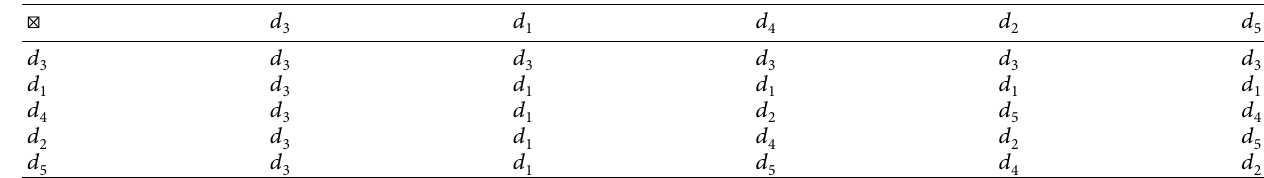
Table 15: Composition of B under the rule ⊠ .